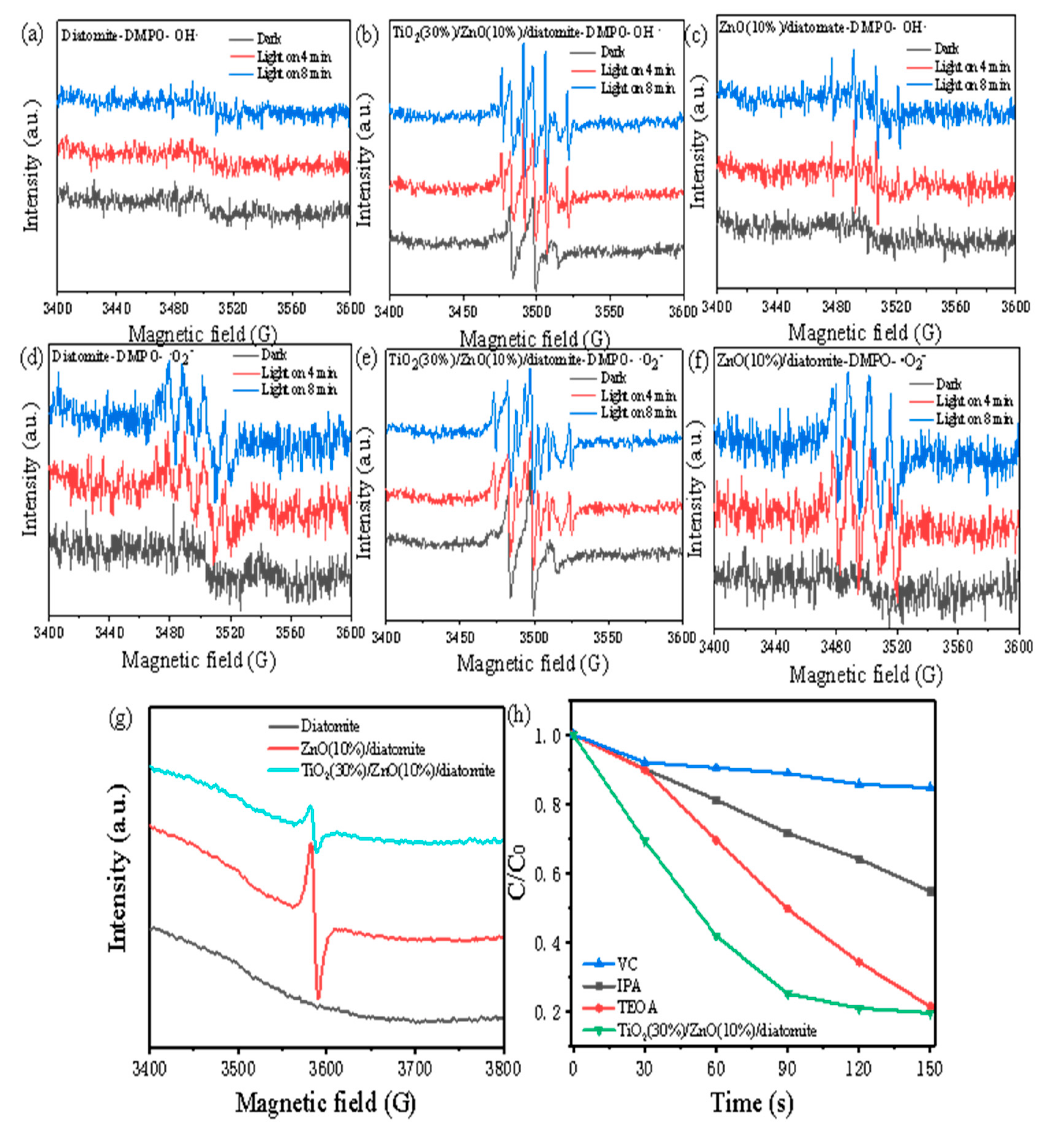
EPR spectra of the samples: ( a ) · OH for diatomite, ( b ) · OH for TiO 2 (30%)/ZnO(10%)/diatomite, ( c ) · OH for ZnO(10%)/diatomite, ( d ) · O − for diatomite, ( e ) · O − for TiO 2 (30%)/ZnO(10%)/diatomite, ( f ) · O − for ZnO(10%)/diatomite, ( g ) oxygen vacancies, and ( h ) degradation rate of MB solution by TiO 2 (30%)/ZnO(10%)/diatomite with the addition of various free radical